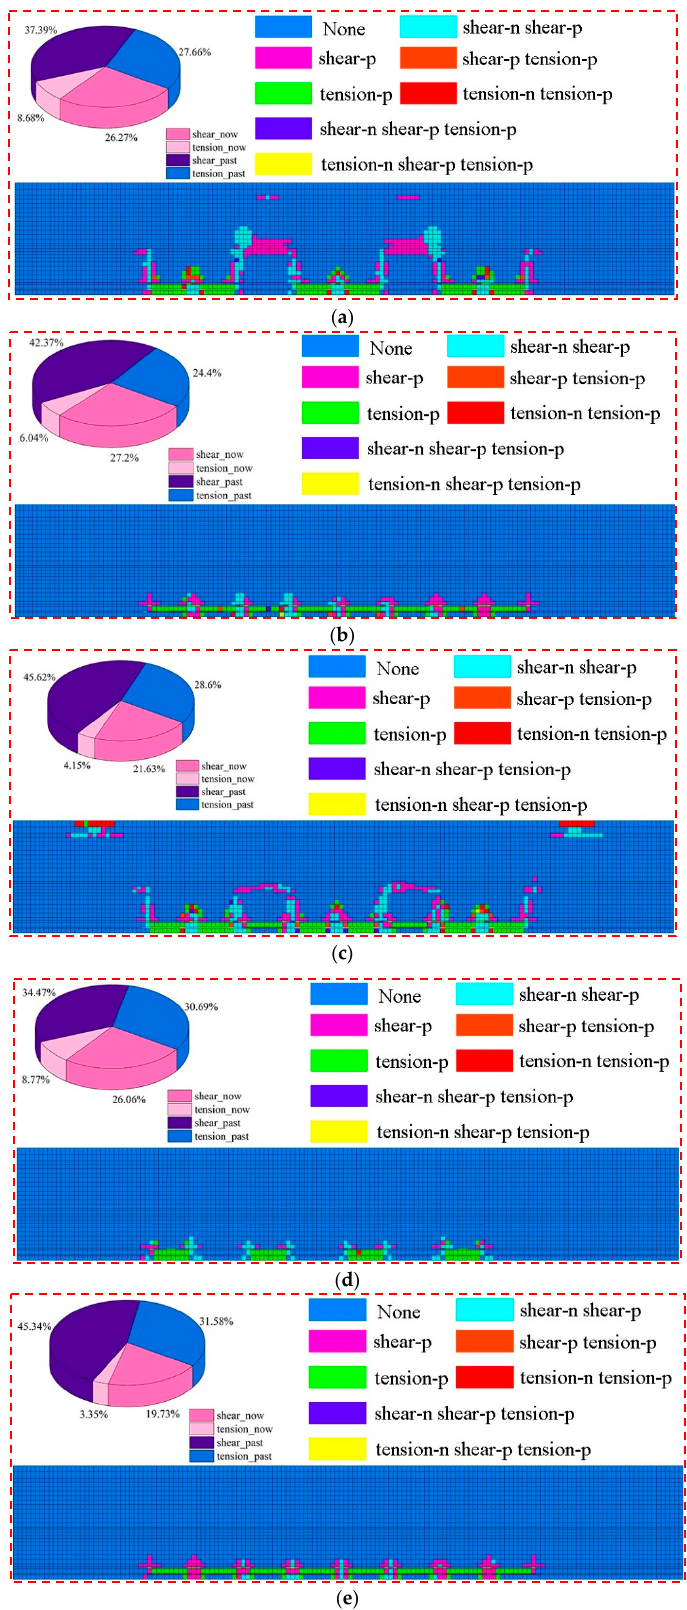
Figure 21. Overlying strata failure degrees of different mining modes; ( a ) large mining width small reserved width. ( b ) Mixed filling mining. ( c ) Local filling–caving multi-face coordinated mining. ( d ) Wide stripe. ( e ) Full filling mining.